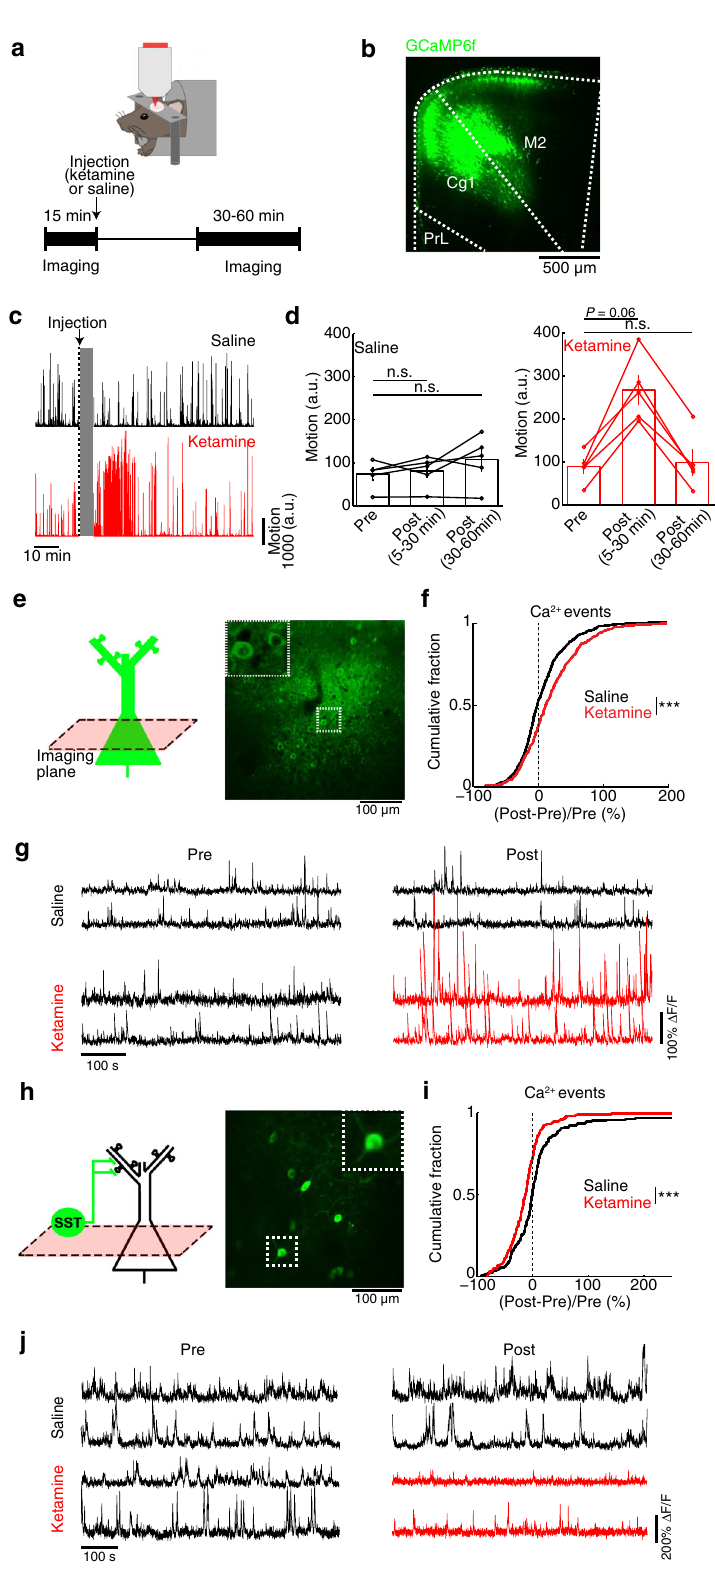
Fig. 2d; Supplementary Fig. 3d). To characterize the temporal dynamics of the aberrant transients, we identi fi ed calcium events that co-occurred in each image frame, thereby separating amplitude (number of events in each frame) from frequency (number of frames with at least one event). Both the amplitude